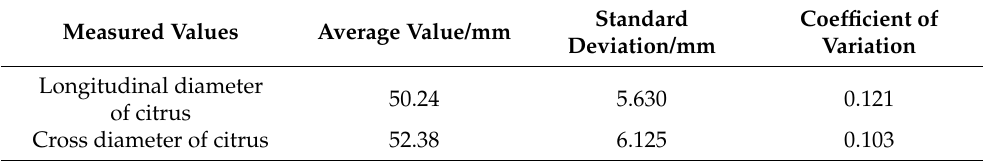
Table 1. Physical characteristics of citrus fruit.